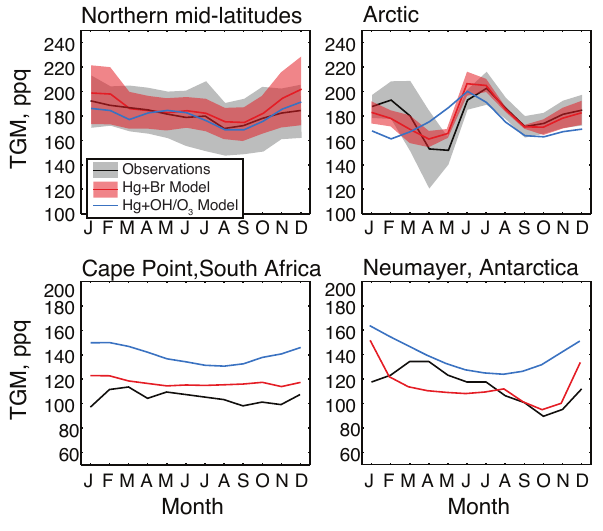
Fig. 7. Mean seasonal variation of total gaseous mercury (TGM) at Arctic, northern mid-latitude, and Southern Hemisphere sites. The northern mid-latitude panel shows an average over 15 sites where monthly mean data are available, including the sites from Selin et al. (2007) plus Andoya and Birkenes, Norway (EMEP 2009); Kuujjuarapik, Canada (Steffen et al., 2005); Athens, Ohio; and Pen- sacola, Florida in the US (Yatavelli et al., 2006, E. Edgerton, per- sonal communication, 2008). Cape Point data are means for 2007– 2008 (F. Slemr, unpublished data). The Arctic panel is an average over 3 sites: Alert, Canada; Zeppelin, Norway; and Amderma, Rus- sia (Steffen et al., 2005, EMEP 2009). Shaded areas show standard deviation among sites for observations and for the Hg+Br model.